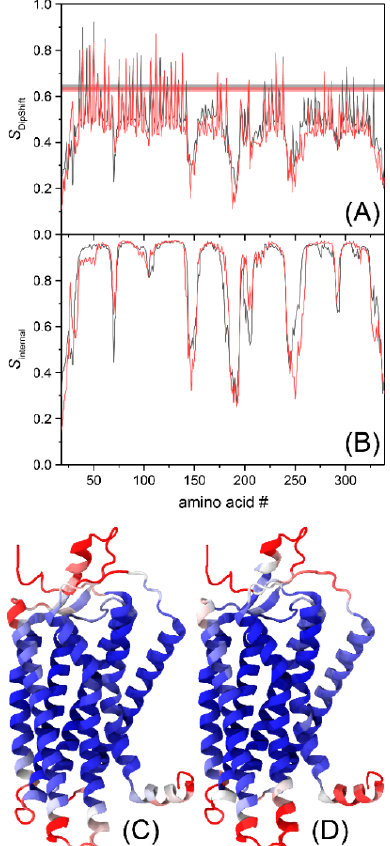
Figure 5. Segmental 1 H- 13 C order parameters determined from the molecular dynamics (MD) simulations. In panel ( A ), the order parameters (arithmetic mean over all three runs) as directly observed in the MD simulations are shown (black: Y1R in the apo state, red: Y1R in the presence of UR-MK299). The experimental values (red and black lines corresponding to the values from Table 2, including the error intervals) are shown for comparison. In panel ( B ), the same analysis was performed on the trajectories, where the overall reorientation of the receptor was removed such that the order parameter now corresponds to the internal order parameter S internal . In panels ( C ) (apo state) and ( D ) (UR-MK299-bound state), the internal order parameter S internal was projected on the Y1R structure using a color scale reaching from 0.5 (red) to 1.0 (blue).